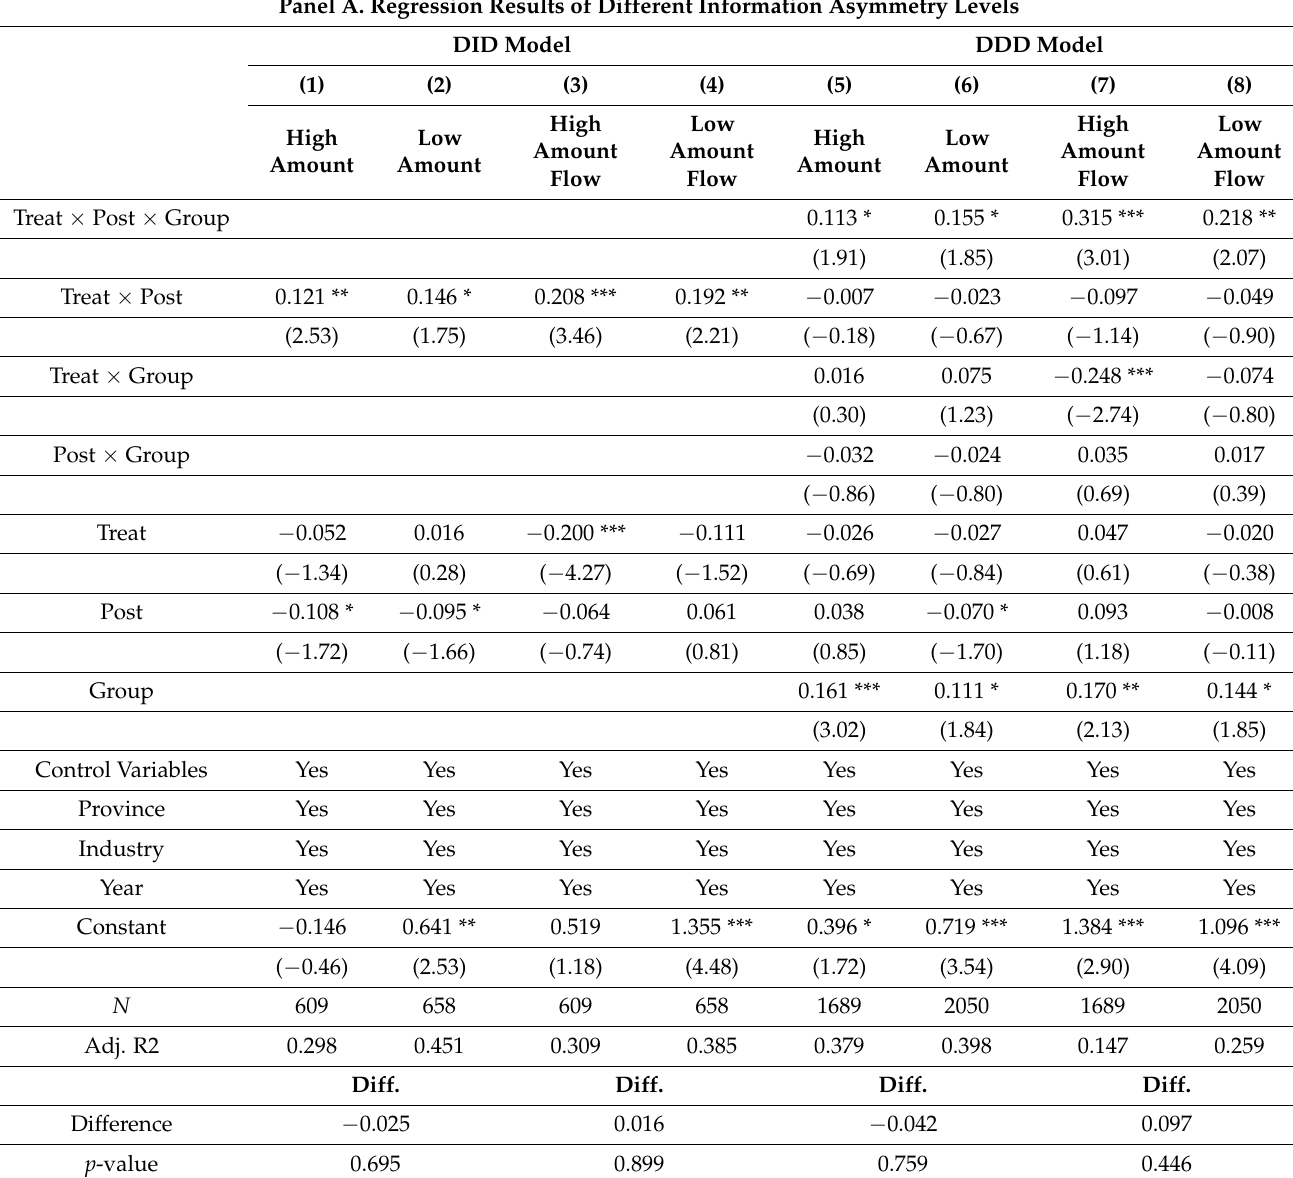
Table 6. Regression results of further analysis. Panel A. Regression Results of Different Information Asymmetry Levels DID